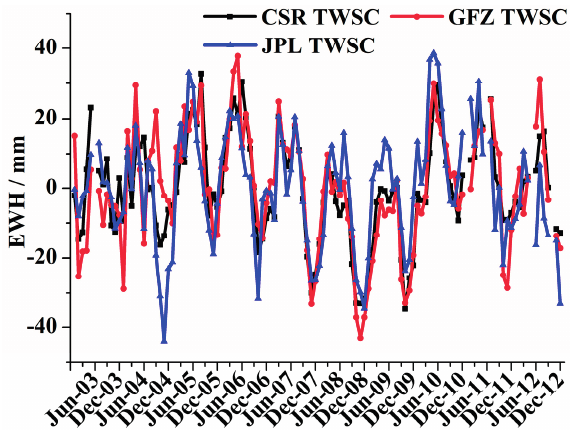
Figure 12. Region-averaged GRACE TWSC estimated from CSR, GFZ and